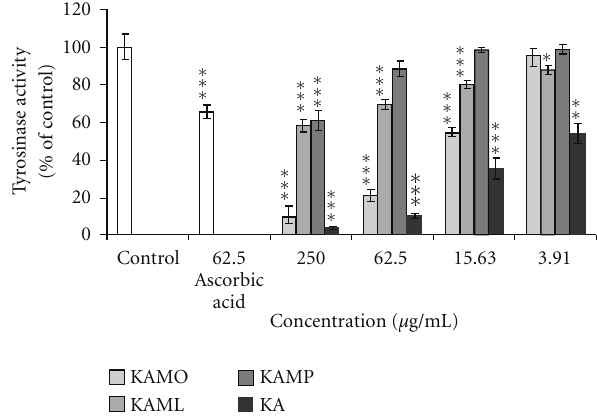
Figure 5: The results of the inhibition of mushroom tyrosinase activity by KAMO, KAML, KAMP, and KA. Denotes ∗ P < 0 . 05, ∗∗ P < 0 . 01, ∗∗∗ P < 0 . 001 compared to α -MSH treated control. Data are presented as means ± S.E.M, and expressed as % of control. 62.5 μ g/mL ascorbic acid was used as reference. n ≥